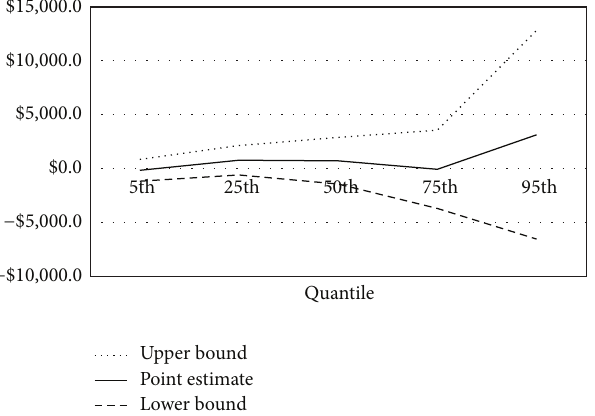
Figure 2: Weighted relationships between residence and nonzero expenditure of hospital inpatient care, adjusted by 10 covariates.